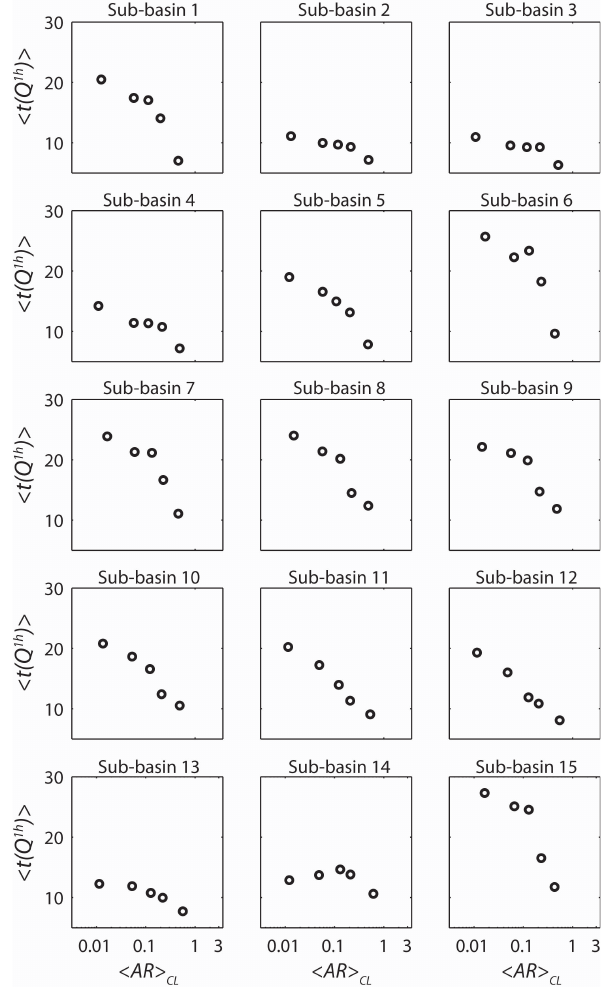
Fig. 8. Relation between < t(Q 1h ) > (measured in hours from t ∗ ) and AR (mmh − 1 ) in each